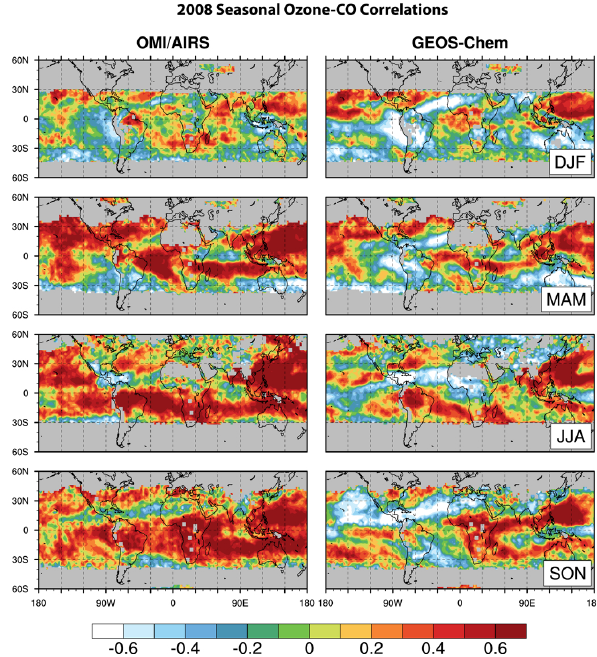
Fig. 2a. Ozone–CO correlation coefficients ( r) for OMI/AIRS and GEOS-Chem for each season of 2008. The correlation coefficients are computed from daily data at 700–400hPa on the 2 ◦ × 2.5 ◦ GEOS-Chem grid. Gray indicates insufficient